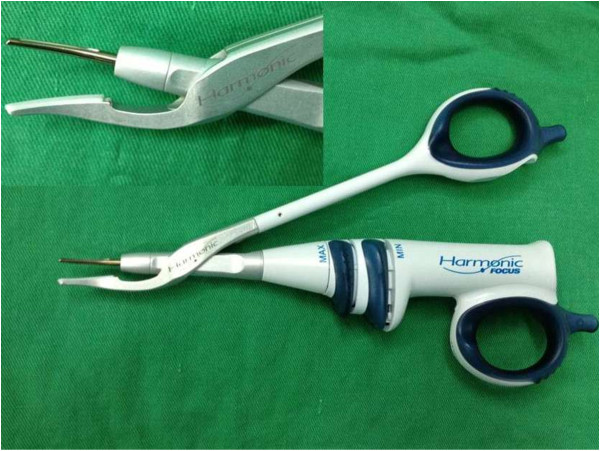
Focus Harmonic Scalpel (Ethicon Endo-Surgery, Inc, Cincinnati, Ohio, USA).